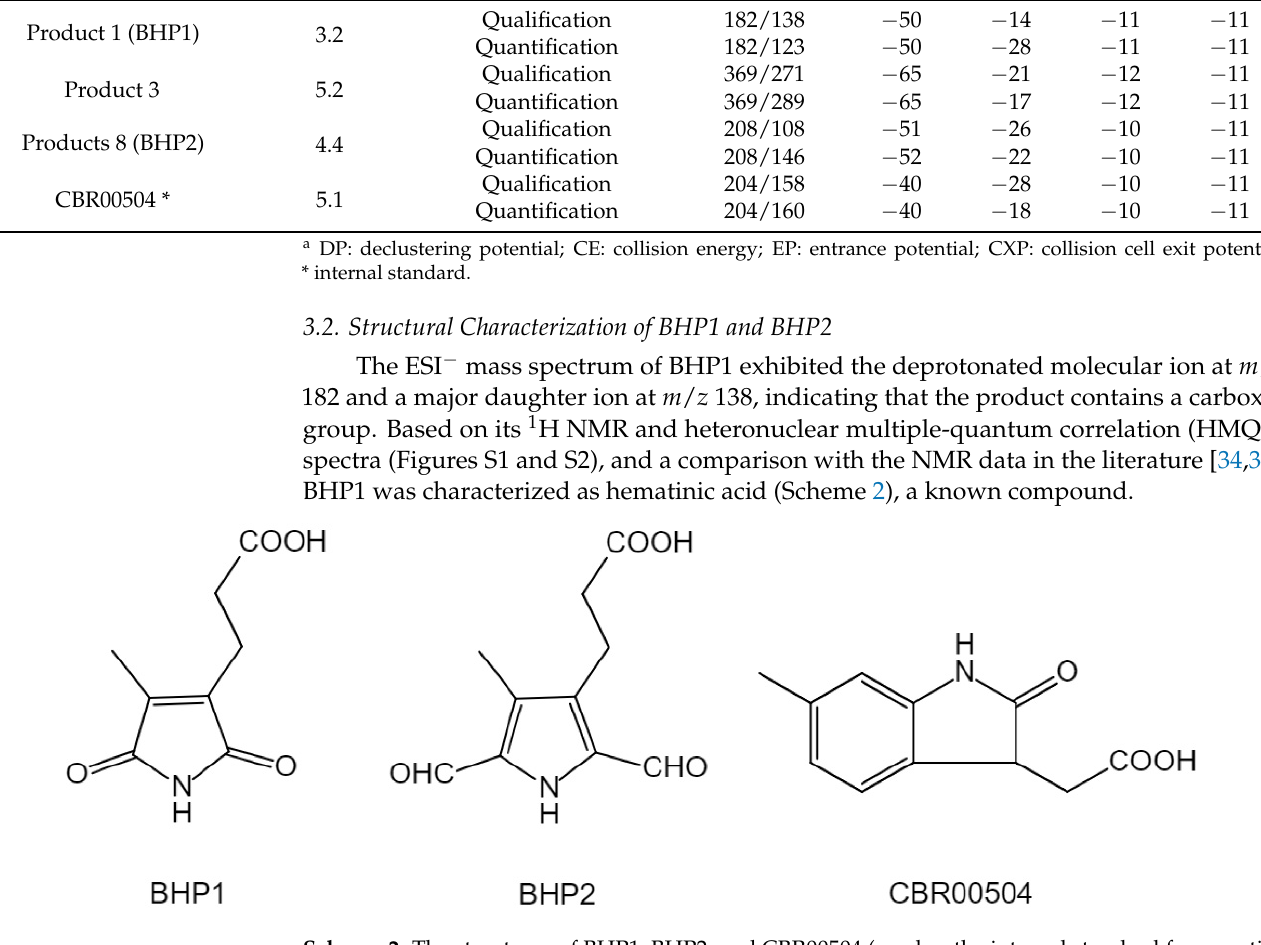
Table 1. The ion transitions and mass spectrometric parameters for LC-MS/MS analyses of product 1, 3, 8, and CBR00504 (the internal standard) under the MRM mode. Retention Qualification or Ion Compound Time (min) Quantification Transitions Product 1 (BHP1)